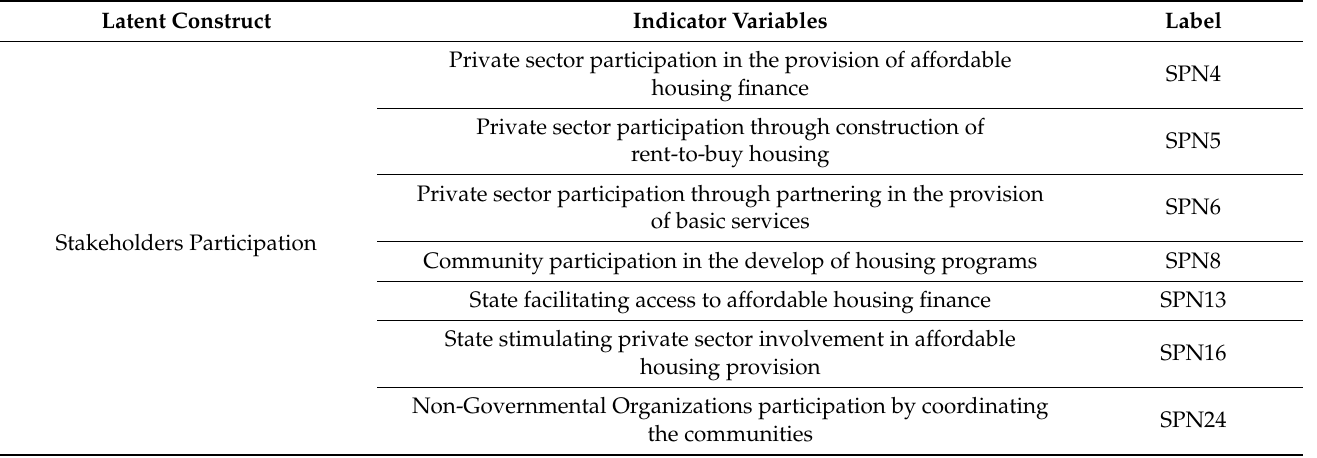
Table 7. Postulated stakeholders participation model.